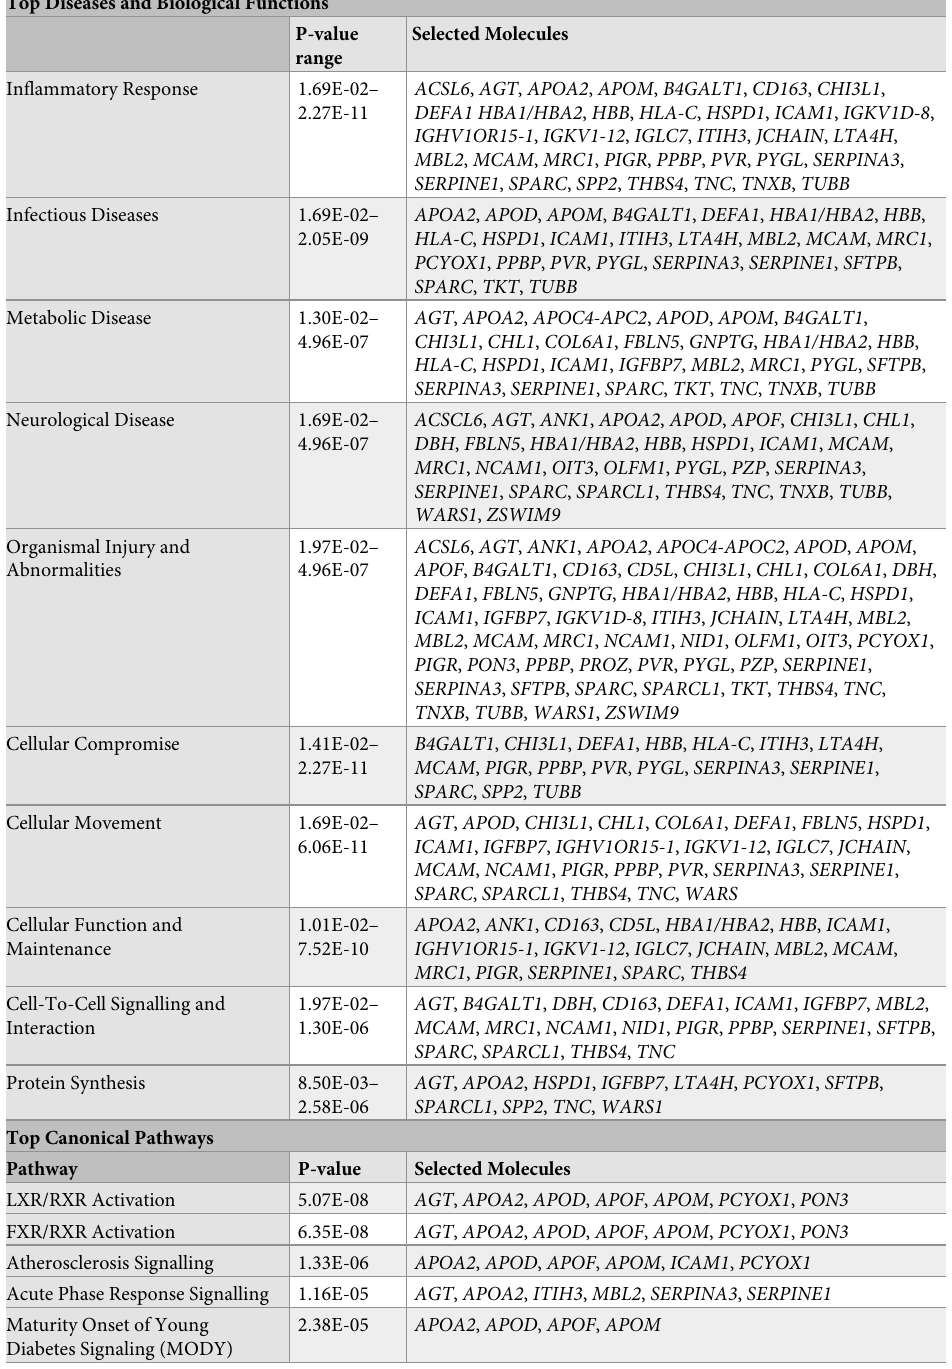
Table 16. Enrichment analysis of proteins associated with COVID-19 severity (patients with COVID-19). Top Diseases and Biological